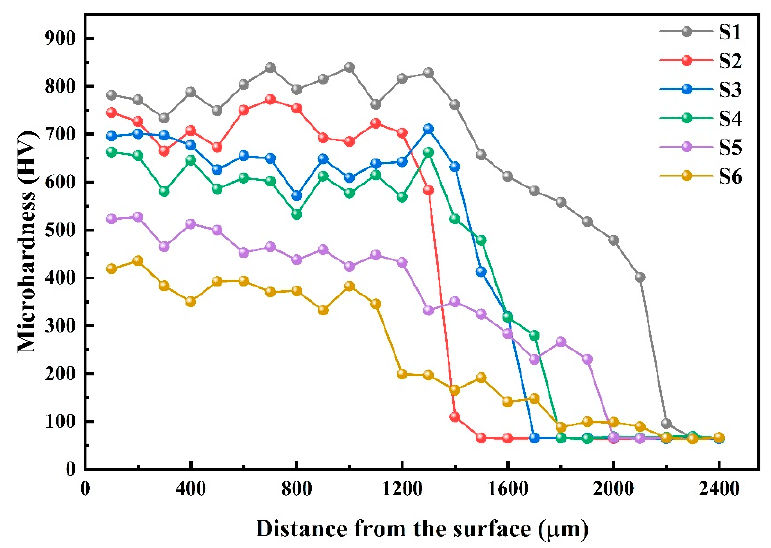
Figure 11. Microhardness distribution of different samples along the depth of the